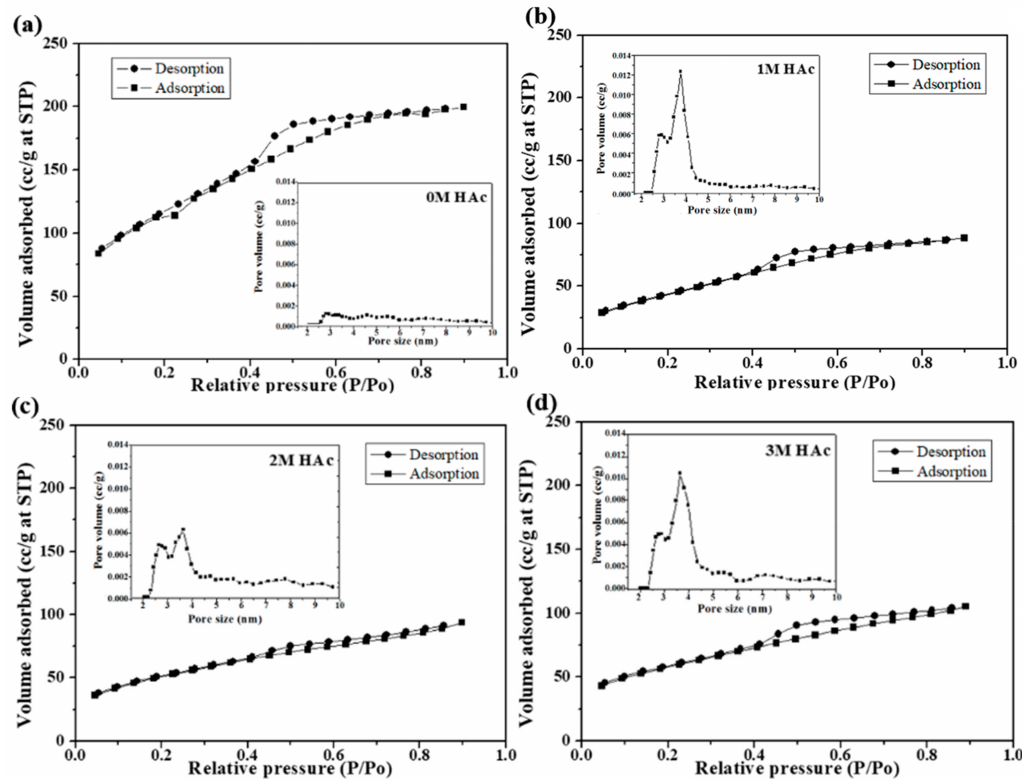
Figure 5. Nitrogen adsorption and desorption isotherms of ( a ) untreated BG powders, and ( b ) 1M, ( c ) 2M, and ( d ) 3M HAc-treated BG powders. The inserts are their corresponding pore size